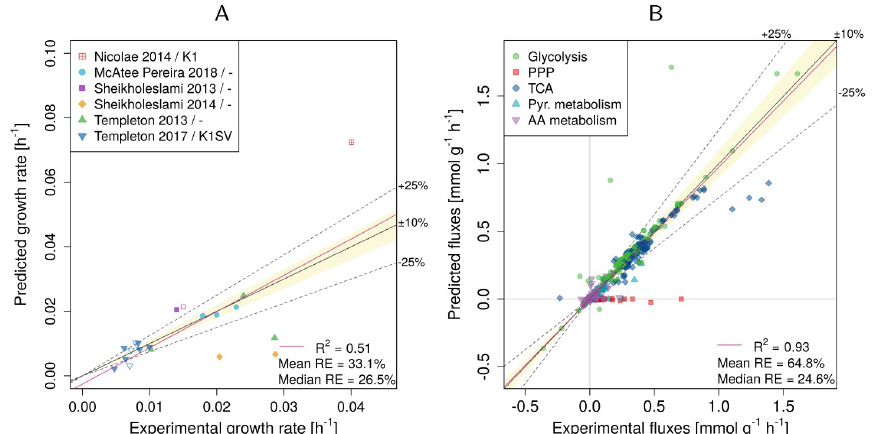
Fig 3. Experimental vs. predicted growth rates (A) and intracellular fluxes (B) after the addition of mATP as constraint. Results are shown for R_biomass_cho as the objective function. RE—relative error. The legend in panel (A) indicates the publication and the used CHO cell line (if the information was available). Empty symbols indicate